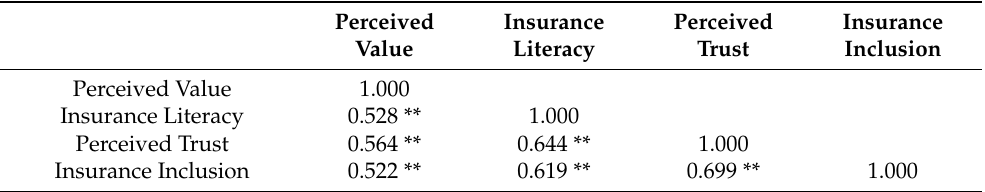
Table 8. Pearson’s correlation results between study